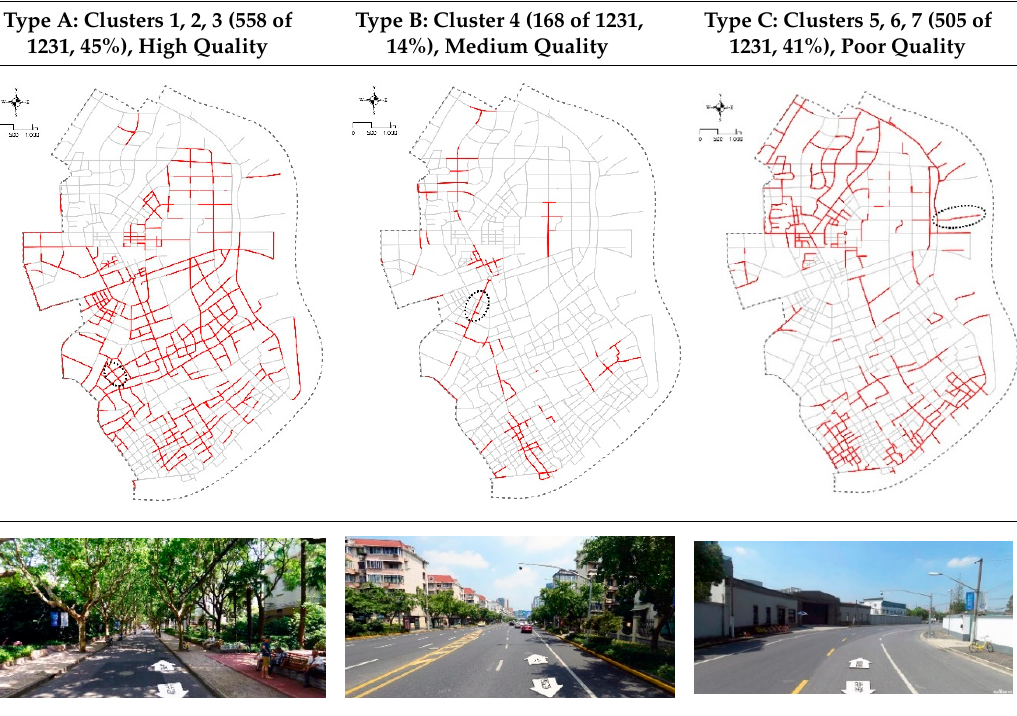
Table 1. Distribution of streets with different quality levels.